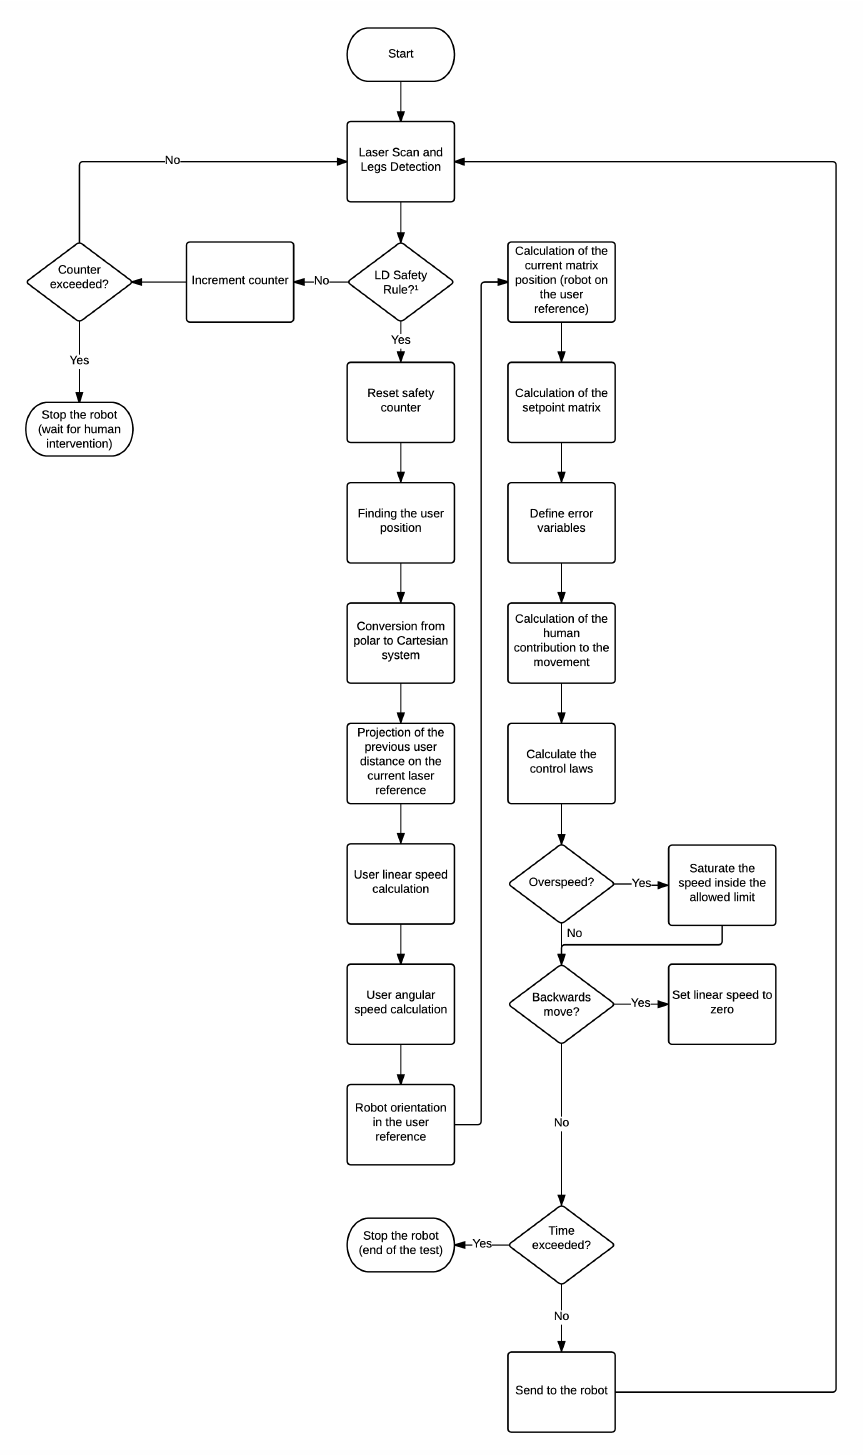
Figure 4. Flowchart of the data acquisition, controller and safety rules applied to the smart